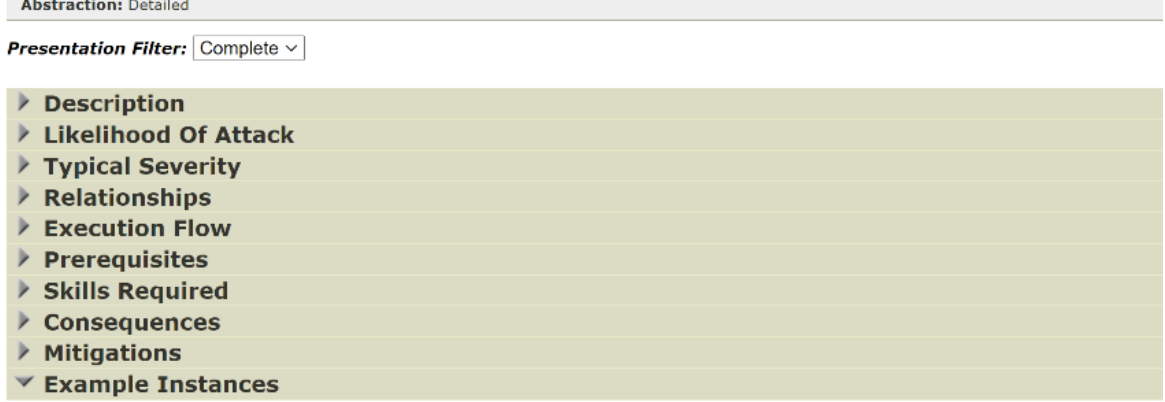
Figure 6. Overview of the tracing based on the Sentence BERT (SBERT) algorithm.